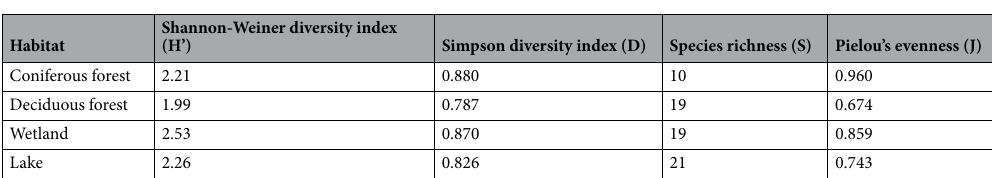
Table 2. Diversity, richness, and evenness indices for the Lindgren funnel collection of the four habitats.